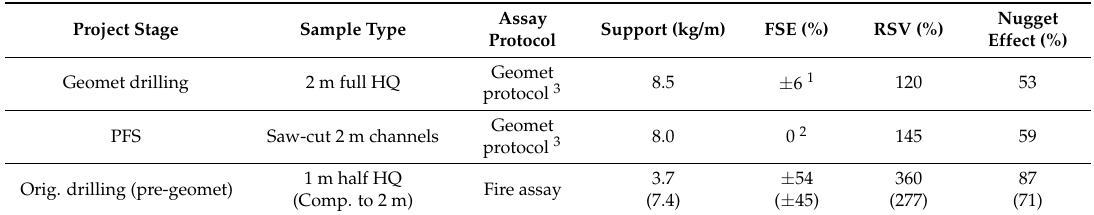
Table 19. Summary of sample type and support with FSE, RSV and nugget effect. All data from the